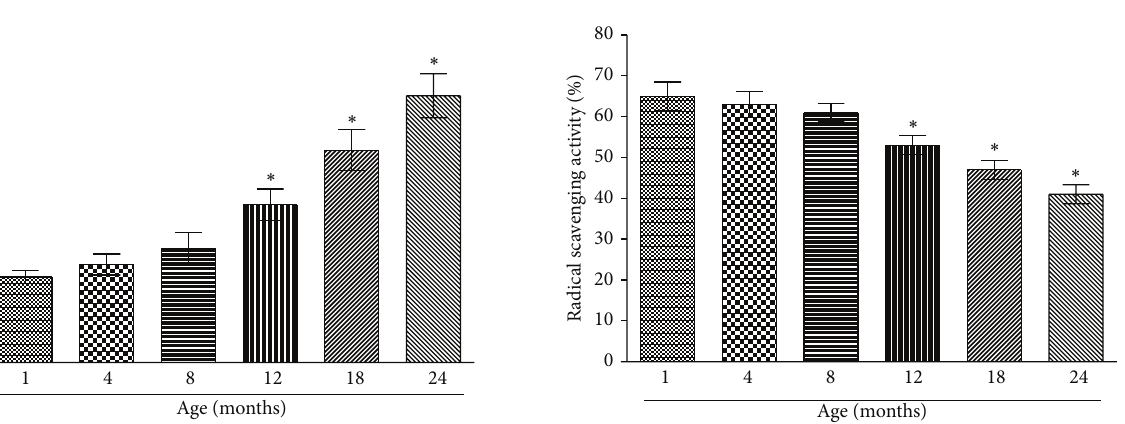
Figure 4: DPPH radical scavenging activity of plasma plotted as a function of rat age. Values are mean ± SEM. ∗ 𝑃 < 0.001 compared to control (1-month-old